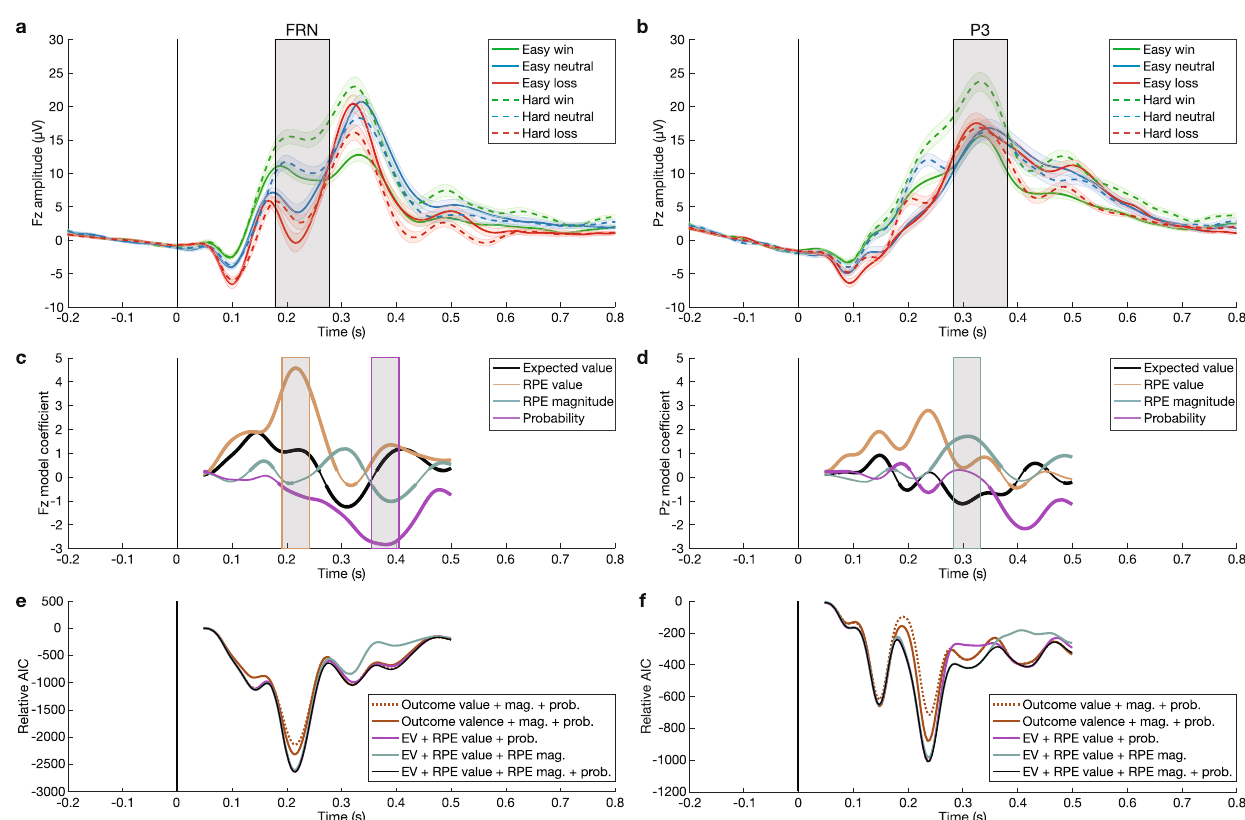
Fig. 2 Single-trial modeling of ERP amplitude reveals a sequence of prediction errors. a Feedback-locked grand-average ERPs at Fz plotted for each condition, with shaded error bars indicating standard error of the mean across 32 participants. FRN is evident as prominent negative de fl ections at Fz ~200 ms post-feedback. Vertical black line shows feedback onset. Gray shading shows 100 ms window used to average FRN amplitude. b Same for posterior electrode Pz, which shows large P3 positivities at ~300 ms. Gray shading shows 100 ms window used to average P3 amplitude. c Model coef fi cients from single-trial multiple regression at each time point from 50 to 500 ms at Fz show a strong early peak of valenced RPE in the FRN window, followed by later probability effect in the P3 time range. Bolding indicates signi fi cant timepoints ( q FDR < 0.05; n = 32 participants). Gray shading shows 50 ms windows used to average ERP amplitude at maximal RPE value and probability effects. d Same for electrode Pz. Note the increased non-valenced RPE magnitude coef fi cient in the P3 window. Gray shading shows 50 ms window used to average ERP amplitude at the maximal RPE magnitude effect. e Comparison of model performance at Fz over time via Akaike Information Criteria (AIC; more negative indicates higher performance) relative to baseline model. RL model with RPE value beats outcome-based models in the FRN window, and model performance drops in the P3 window when probability is excluded. f Same for Pz. RL model performance drops during P3 peak window when RPE magnitude is excluded, while RL model performance drops during late positivity window when probability is excluded. See Supplementary Fig. 5 for RL model performance (R 2 ) across electrodes, which peaks in the FRN time window for Fz and the P3 time window for at Fz than outcome value or valence models (see Supplementary Fig. 4c – f for outcome-based model coef fi cients; see Supplemen- tary Table 2 for AIC model comparison values averaged within peak model coef fi cient windows). The model with binary outcome valence performs better than the outcome-based model with scalar value, and these model results hold for both mean window and peak-to-peak estimates of FRN amplitude (Supple- mentary Fig. 3e,f). The only difference between outcome value and outcome valence models is whether neutral trials in easy and hard blocks are treated as outcomes with identical values (zero) or as omissions of expected rewards with opposite valence (1 or − 1).